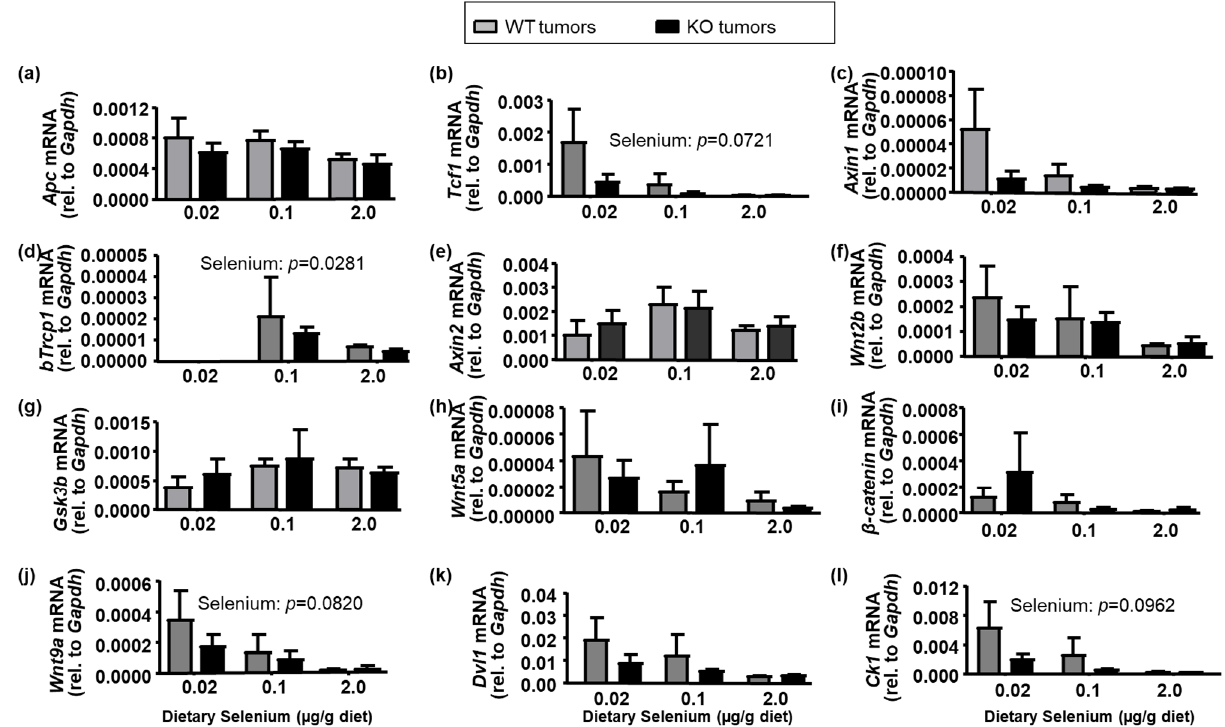
Figure 3. Wnt/ β -catenin signaling pathway in colon tumors. mRNA was isolated from colorectal tumors of AOM/DSS- treated mice, reverse-transcribed to cDNA, and quantitatively assessed with gene-specific primers for ( a ) adenomatous poliposis coli ( Apc ), ( b ) T cell factor 1 ( Tcf1 ), ( c ) Axin1 , ( d ) β -transducin repeat containing E3 ubiquitin protein ligase pseudogene 1 ( bTrcp1 ), ( e ) Axin 2, ( f ) wingless-type MMTV integration site 2b ( Wnt2b ), ( g ) glycogen synthase kinase 3 β ( Gsk3b ), ( h ) Wnt5a , ( i ) β -catenin, ( j ) Wnt9a , ( k ) human homolog of the Drosophila dishevelled gene ( Dvl1 ), and ( l ) casein kinase I ( Ck1 ). mRNA levels for bTrcp1 in selenium-deficient mice were below limits of detection. Means are